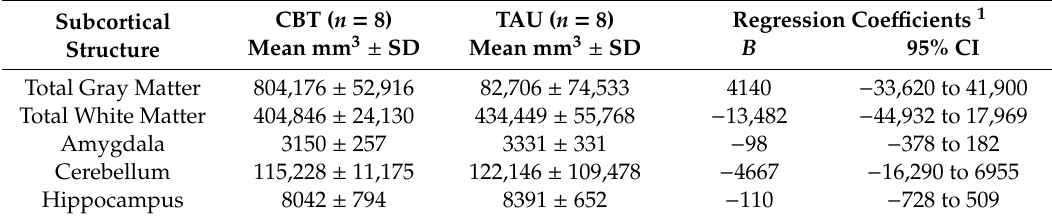
Figure 3. Scatterplots showing correlations between changes in maternal mood symptoms during pregnancy regardless of treatment status (defined as the di ff erence in symptom score of the Beck Depression Inventory (BDI-II, a & b) and the Beck Anxiety Inventory (BAI, c & d) before and after treatment in a longitudinal study in children built on a pilot Randomized Controlled Trial, comparing maternal antenatal Cognitive Behavioral Therapy (CBT, N = 8) to Treatment as Usual (TAU, N = 6)) and cortical thickness of the children’s brain, approximately six years postpartum. Regions shown are those regions that showed increased cortical thickness in the children from the CBT relative to the TAU group (right hemisphere). X-axis: BDI = Beck Depression Inventory, BAI = Beck Anxiety Inventory. Higher scores indicate a better response to treatment. Y-axis: Mean Cortex Thickness Ratio = (mean cortex thickness region of interest (mm) / estimated Total Intracranial Volume(mm)); * 1,000,000. Green diamonds and slope = CBT, blue diamonds and slope = TAU. Table 5. Subcortical volumetric di ff erences in children aged approximately six years, in a longitudinal study built on a pilot Randomized Controlled Trial, comparing Cognitive Behavioral Therapy (CBT) and Treatment as Usual (TAU) for maternal antenatal